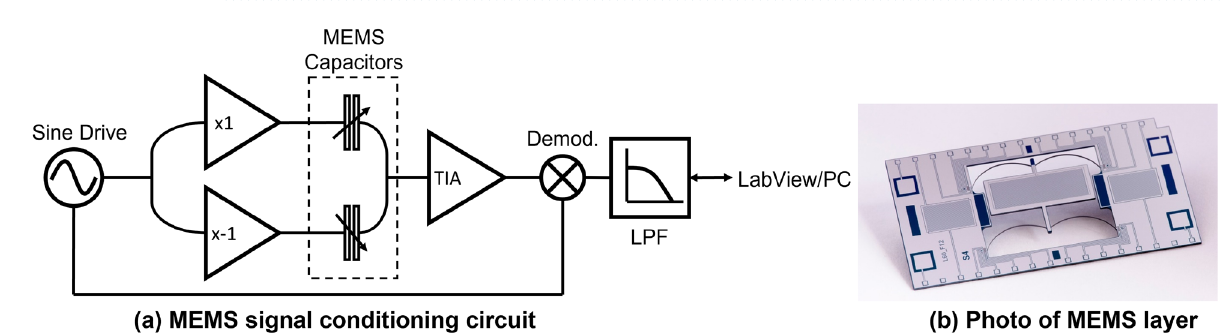
Figure 6. An illustration of the different components of the experimental set up: ( a ) represents the lock-in based signal conditioning of the MEMS sensor, and ( b ) is a photo of a fully-released MEMS layer (courtesy: Kelvin Nanotechnology